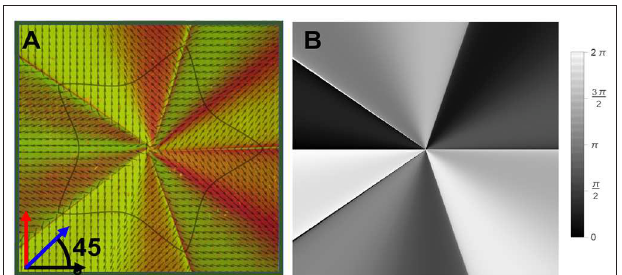
FIGURE 5 | Experimental observation of the optic axis distribution of the SVAP b n 3 ( a 1, m 5, n 1 1 / 2, and n 2 4 / 3). (A) Microscope image of = = = = = = the SVAP between crossed polarizers + birefringent compensator plate at 45 ◦ . This image reveals the optic axis pattern underlying the SVAP ( Figure 4A ), which is displayed in the image overlay. The image was recorded when illuminating the sample with white light, sandwiched between crossed polarizers, and inserting, between the sample and the analyzer, a birefringent λ -compensator ( λ 550 nm) with the optic axis rotated by 45 ◦ . The arrows in = the lower left corner sketch the axes orientations of the input linear polarizer (black arrow), the output analyzer (red arrow), and the λ -compensator (blue arrow). (B) Optical transverse phase profile associated with the optic axis pattern in (A) —the same as in Figure 1B —here replicated for the sake of comparison.